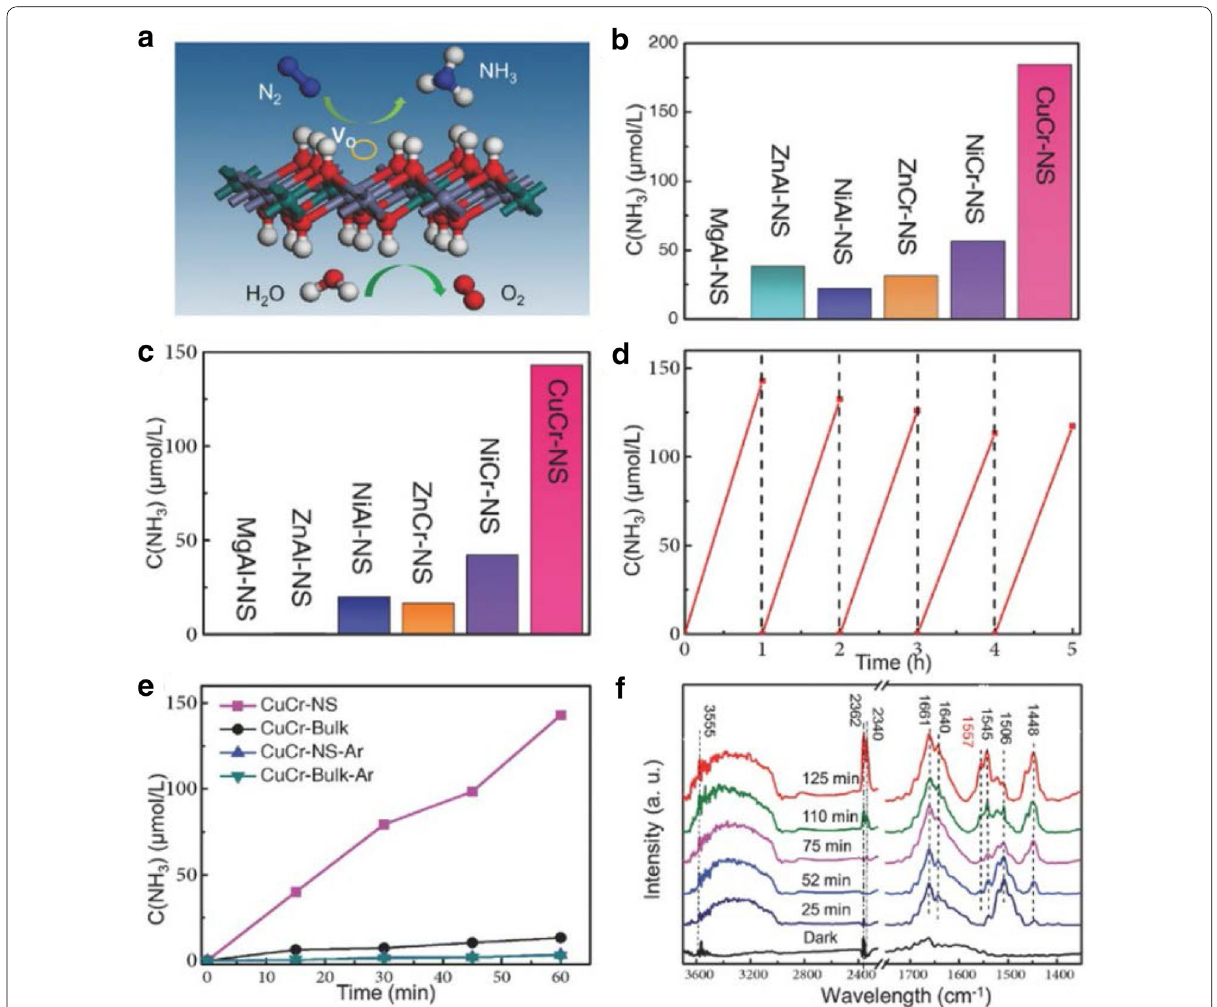
Fig. 10 a Illustration of the N 2 fixation process. b , c NH 3 yield over a 1 h test period on different LDH photocatalysts with UV‑vs illumination. d Catalyst stability tests performed for CuCr‑NS in N 2 under visible‑light illumination. e Time‑dependent NH 3 evolution under N 2 and Ar. f In situ IR spectra recorded for CuCr‑NS under N 2 during 125 min UV–vis illumination (Reproduced with permission [50] Copyright 2017 Wiley – VCH